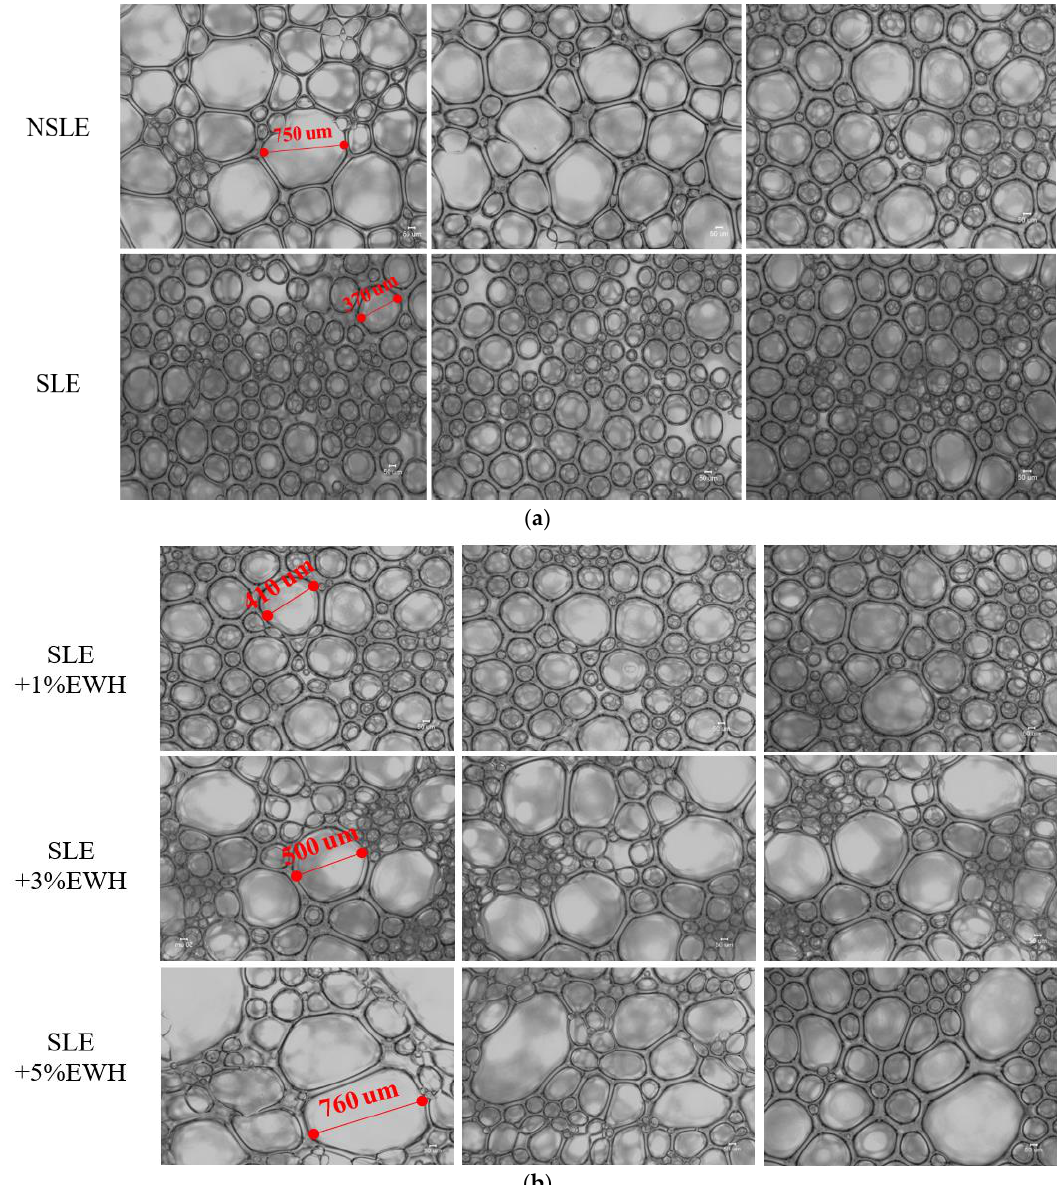
Figure 3. Micrographs (50×) of foam made with ( a ) non-sterilized liquid egg white (NSLE) and sterilized liquid egg white (SLE) and ( b ) SLE supplemented with 1%, 3%, or 5% egg white hydrolysate (EWH).